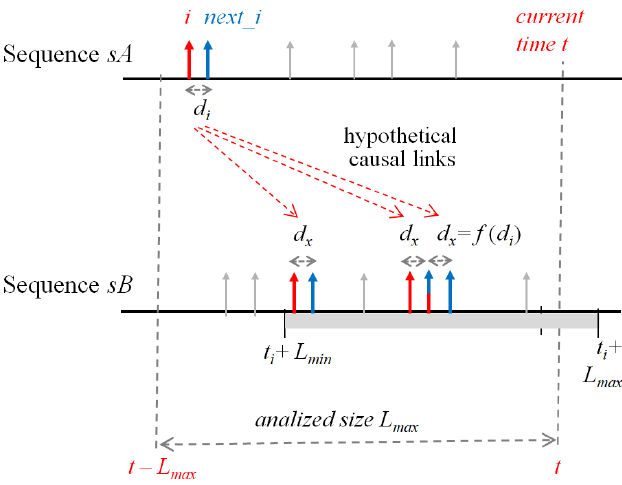
Figure 1. Illustration of the search of cause–consequence pairs of the WCP2 algorithm. This algorithm transforms the solar electromagnetic (EM) flux, e.g., SXR, and a particle flux, e.g., a differential proton flux, into the bit-based sequences sA and sB , respectively. The extreme flux enhancements (calculated as first time derivatives) are “1”s, otherwise the values are “0”s. This forecasting approach assumes that, during a magnetic connection, an extreme EM enhancement is associated with several extreme particle flux enhancements. By making this assumption, at the current (real) time t , WCP2 analyzes the most recent L -size sequence, trying to estimate the maximum number of possible cause-consequence pairs. If the hypothetical maximum number of pairs is larger than a threshold n , WCP2 concludes that there is a magnetic connection at the current time t . The aforementioned thresholds are empirically encountered for maximizing the CSI forecasting index.